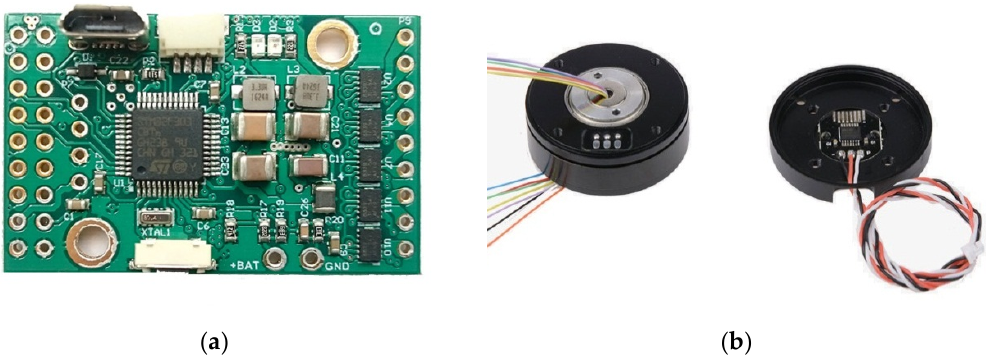
Figure 4. Details of the gimbal control system. ( a ) 3-axis stabilization controller (BaseCam SimpleBGC 32-bit Tiny); ( b ) HT3505 brushless DC motor with AS5048A magnetic rotary encoder.